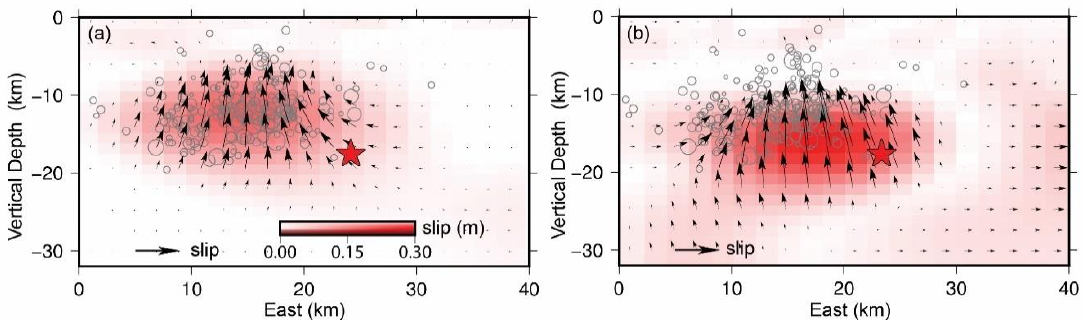
Figure 6. Estimated slip distribution of ( a ) the south dipping model and ( b ) the north dipping model. Red stars denote the epicenter of the main shock derived from sequence relocation [12]. The x-axis is the distance along the EW direction (units: km) and the y-axis is the vertical depth (units: km).